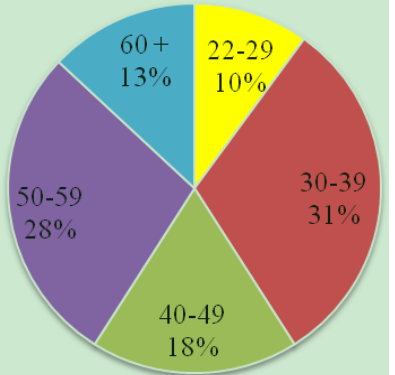
Figure 1. Educate to Eradicate partner teacher age